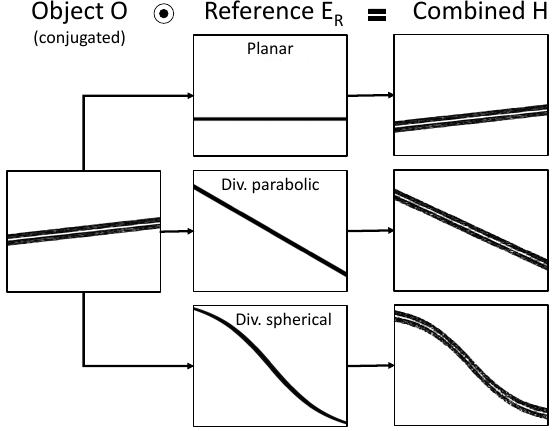
Figure 7. Geometric interpretation in phase space of the Hadamard product of an object wave O and distinct reference waves E R , see Equation (1), yielding a hologram. O used in this figure is the complex-conjugated wave of Figure 6, after up-sampling it by a factor of 4 in order to avoid